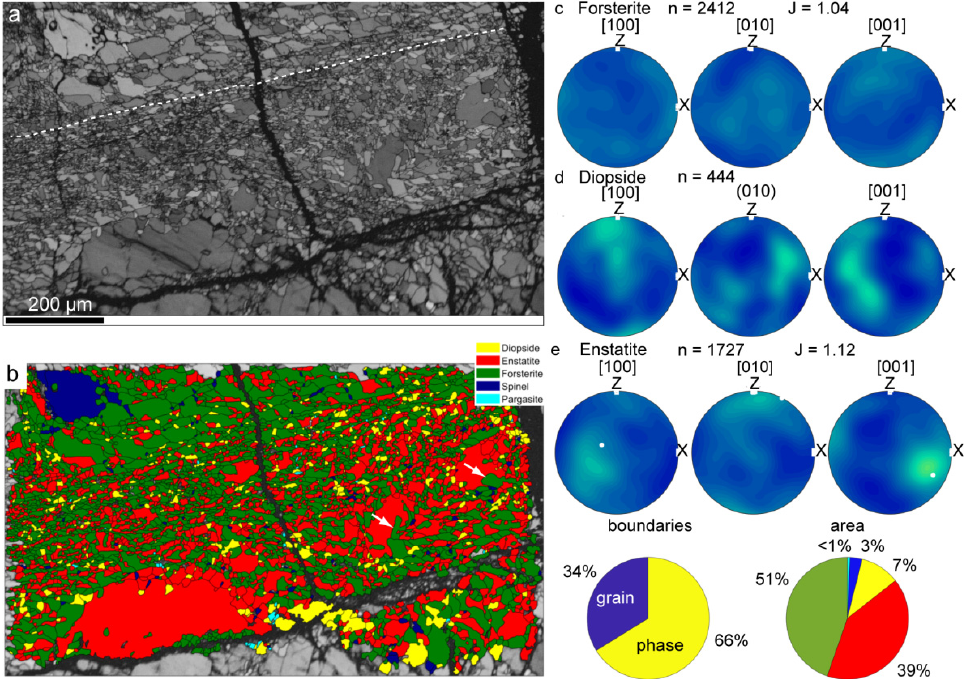
Figure 11. ( a ) Band contrast image of a fine-grained layer (ROI19). Cracks, parallel to the layer, go through the fine-grained part of the layer (dashed white line). There are more cracks parallel to this layer. ( b ) Phase map of the fine-grained layer. At the top is an olivine-rich layer with small grains of other phases on the grain boundaries. The grain shapes are very irregular in the fine-grained layer. Bigger opx grains at the right of the map show embayments of olivine (white arrows). ( c – e ) CPO of forsterite, diopside and enstatite.